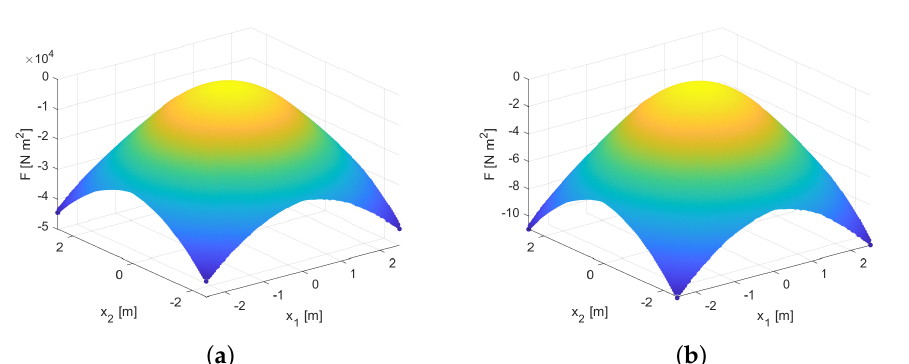
Figure 6. Representation of the stress potential assuming ( a ) r 0 = 0.5 and p 0 = 1; ( b ) r 0 = 1 and p 0 = 1.